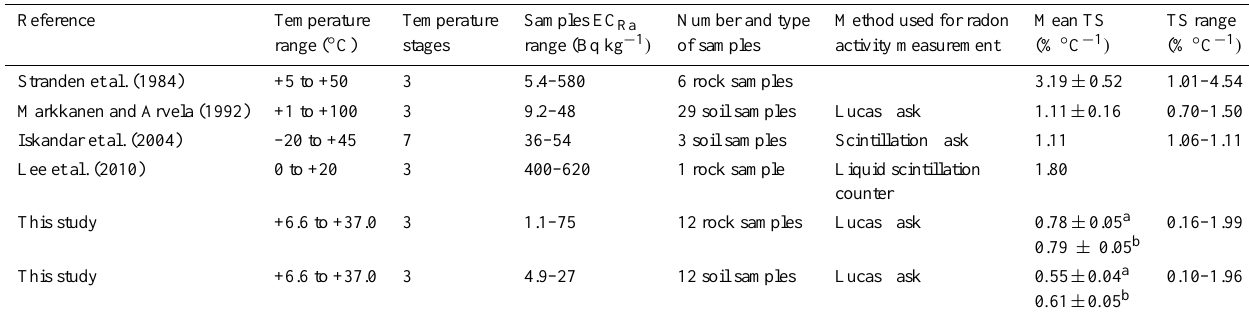
Table 1. Summary of results and experimental conditions for the determination of TS. Our experiments are compared with four previous studies.